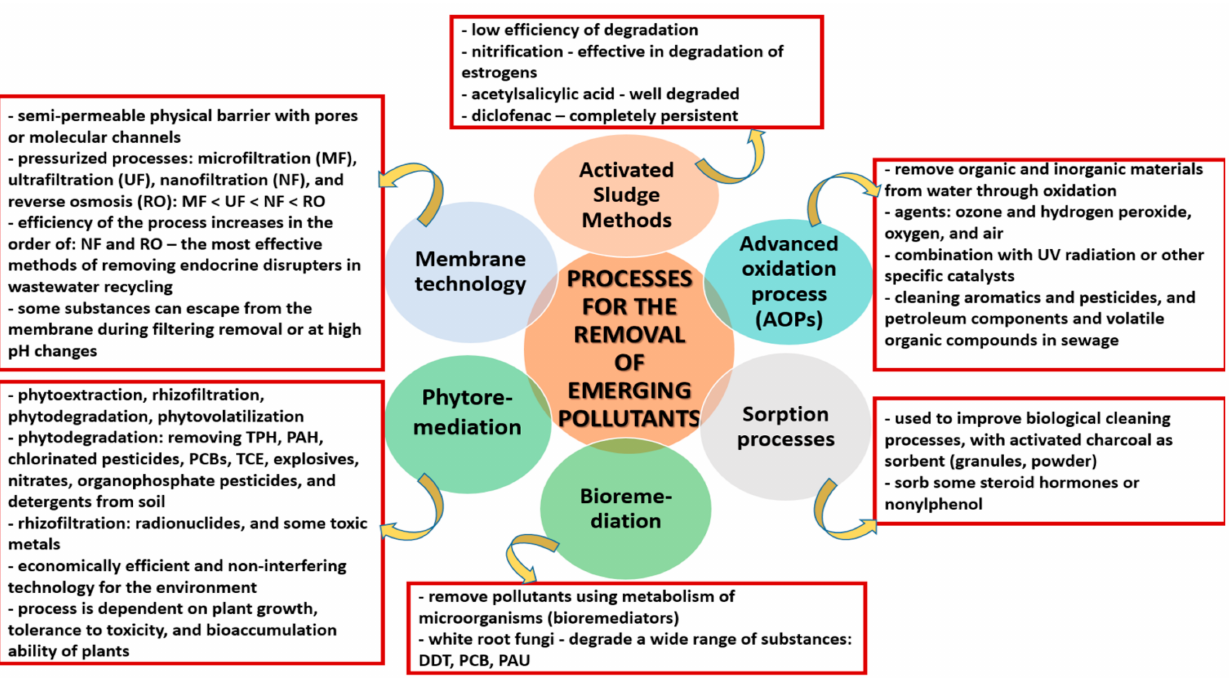
Figure 7. Physico-chemical and biological processes applied for the removal of emerging pollutants from the environment (developed mainly based on information from